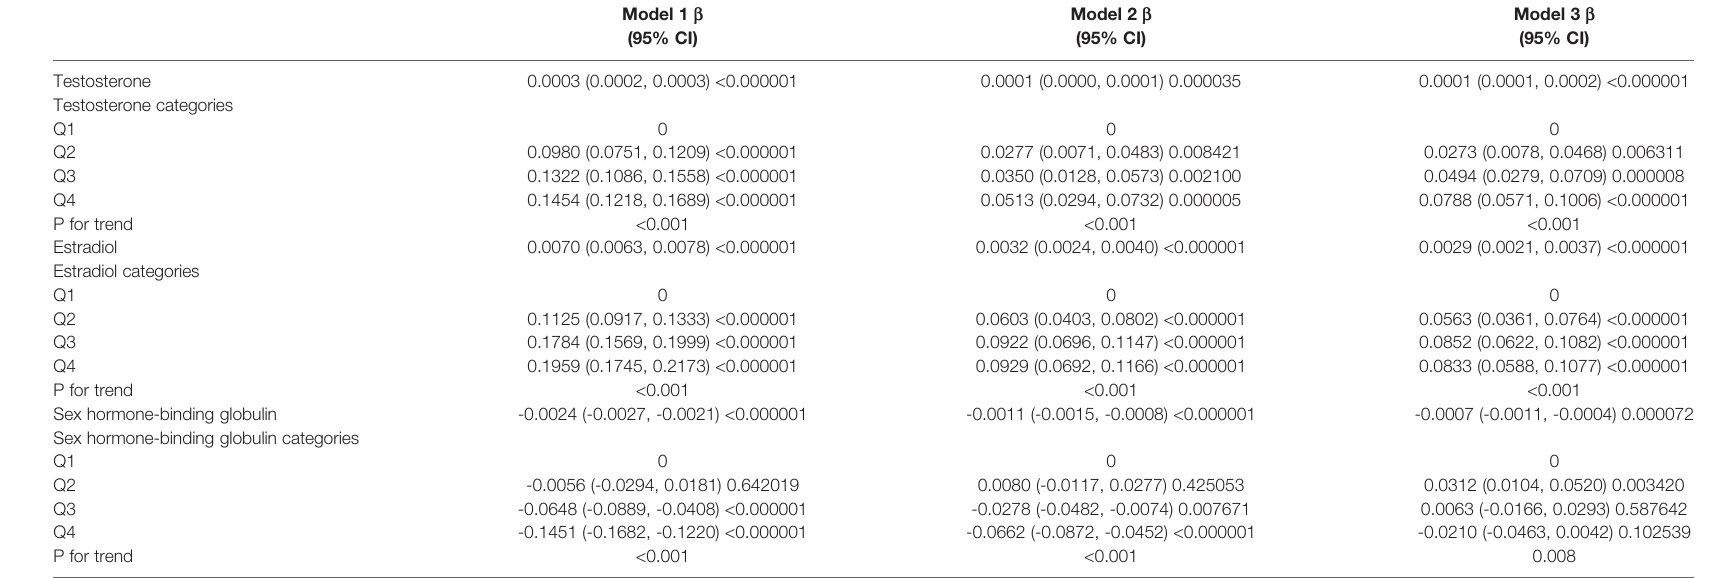
TABLE 3 | Association of serum testosterone, estradiol, and sex hormone-binding globulin levels with total bone mineral density in